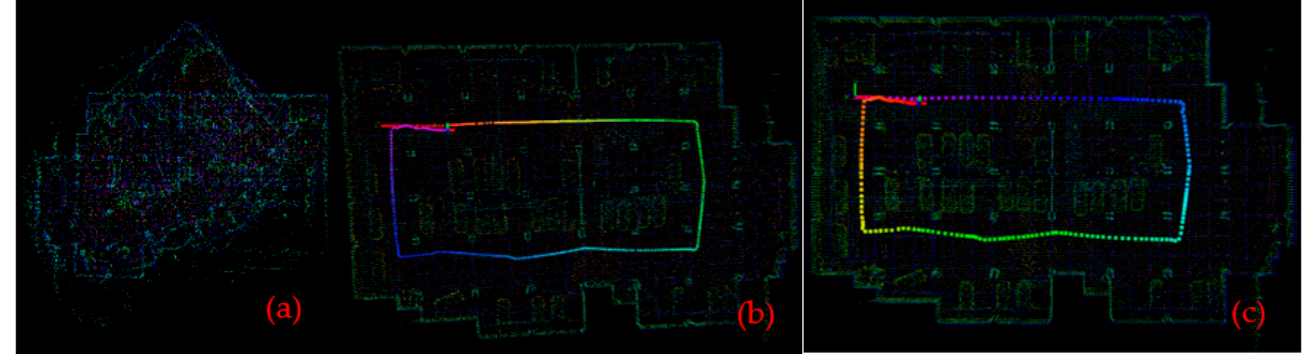
Figure 12. Constructed map for scene #2. ( a ) By LOAM; ( b ) by LeGO-LOAM; ( c ) by LeGO-LOAM-SC.